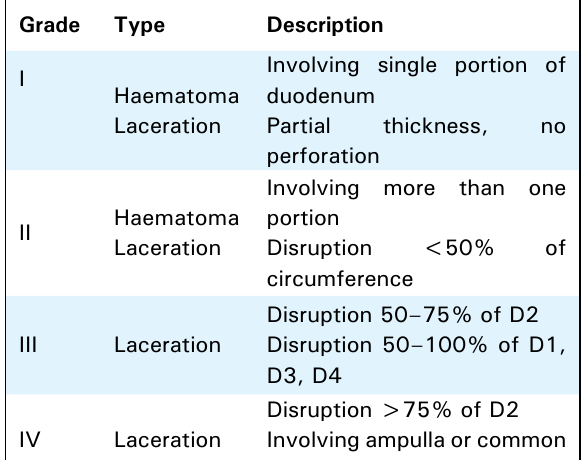
table 2. Duodenal organ injury